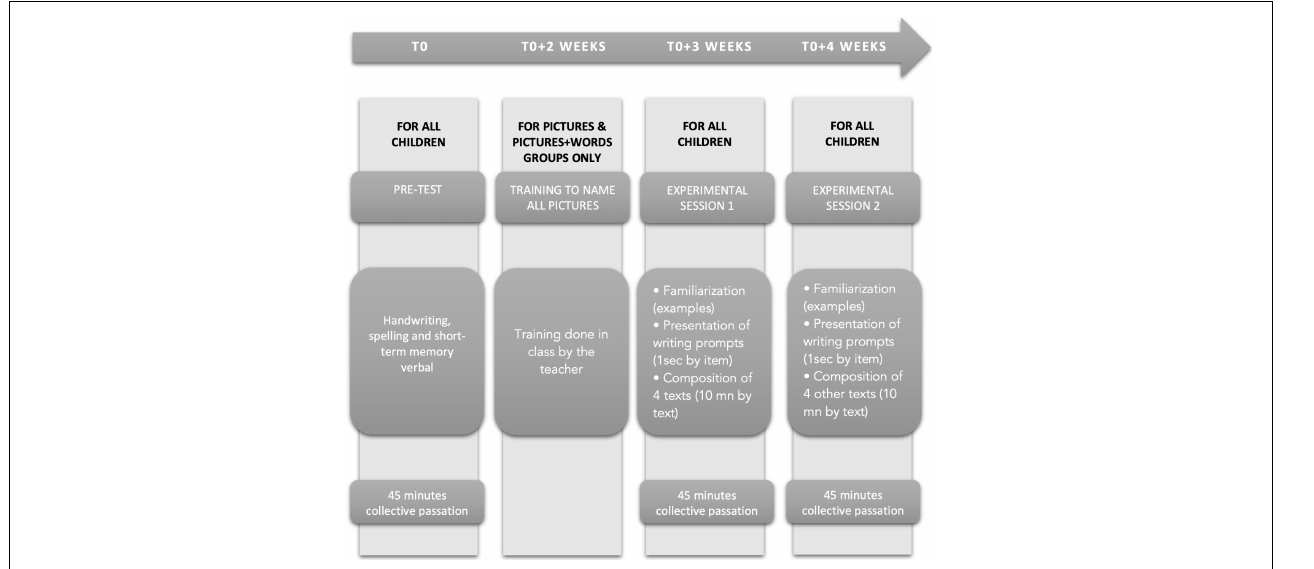
FIGURE 1 | General design of the procedure